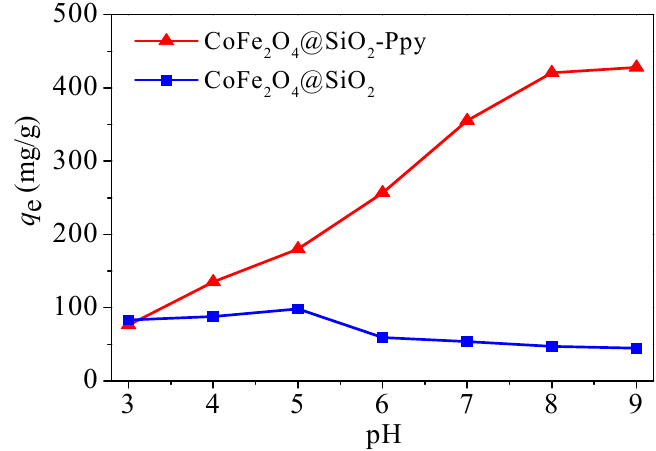
Figure 10. Effect of pH on removal capabilities of CoFe 2 O 4 @SiO 2 and CoFe 2 O 4 @SiO 2 -Ppy.